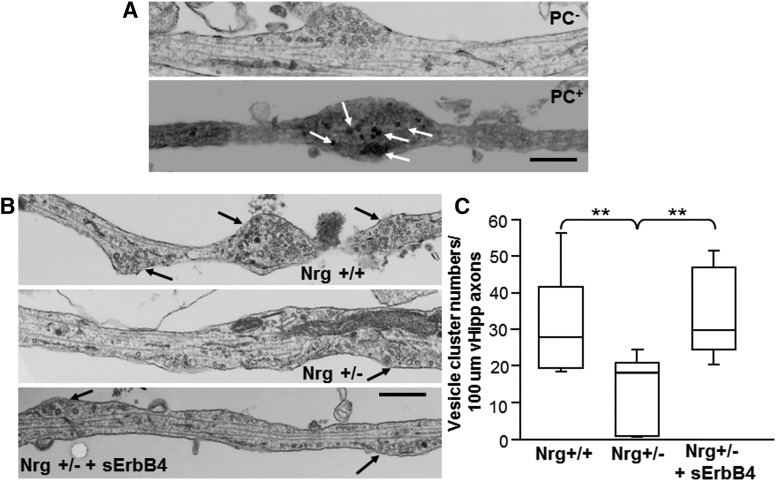
ErbB4-induced back-signaling reverses ultrastructural defects in the number of SV clusters. A, Representative electron micrographs of control (nonphotoconverted, PC-, top) and photoconverted (PC+; bottom) SVs along vHipp axons are shown (scale bar, 500 nm). The arrows indicate electron-dense material resulting from photoconversion of FM1-43 dye that is confined to the lumen of photoconverted s SVs. B, Representative electron micrographs of Nrg+/+ (top), Nrg+/− (middle), and Nrg+/− after 24 h of treatment with soluble ErbB4 (bottom) vHipp axons are shown. The arrows indicate the location of vesicle clusters (defined as ≥15 vesicles within less than a vesicle diameter of one another; scale bar, 500 nm). C, Box plot of pooled data (>40 axons from 2 separate experiments) shows a significant decrease in the number of vesicle clusters along axons from Nrg+/− compared with Nrg+/+; **p < 0.01. Following 24 h of treatment with 2-ng/ml soluble ErbB4-ECD, the total number of vesicle clusters per 100-µm axon length along Nrg+/− vHipp axons was rescued to levels comparable to Nrg+/+ control (**p < 0.01).